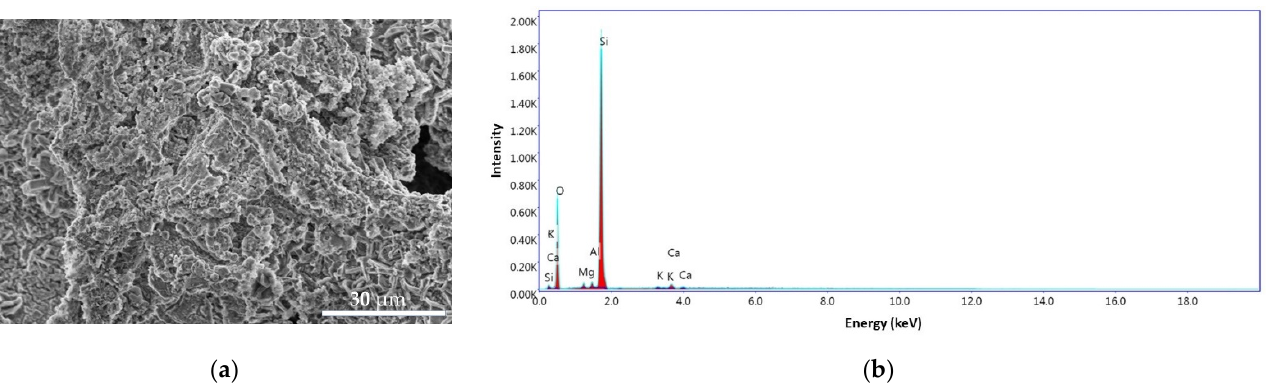
Figure 11. SEM images for BPA sample at 4000× ( a ) and the EDS pattern ( b ).